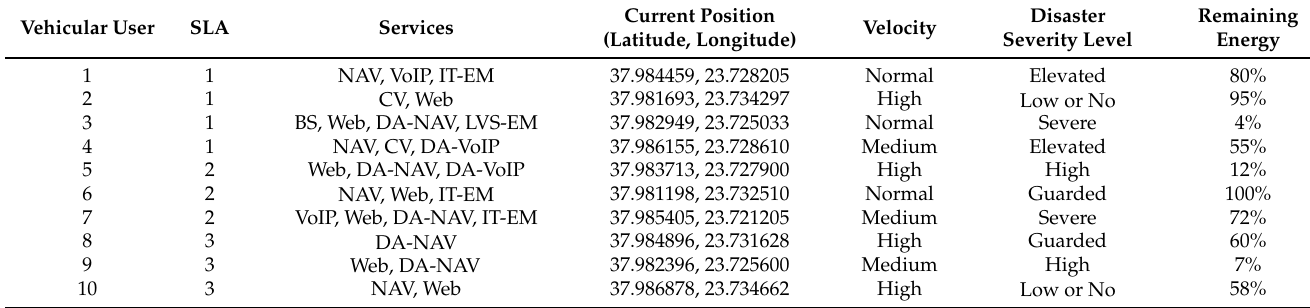
Table 2. The monitored vehicles’ status.